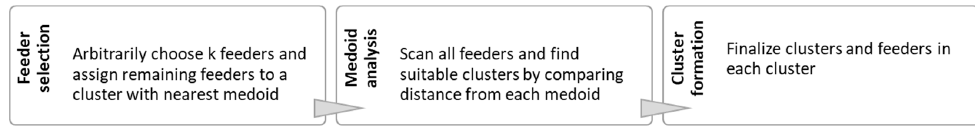
Figure 20. Overview of distribution circuit clustering method with EVs [52].